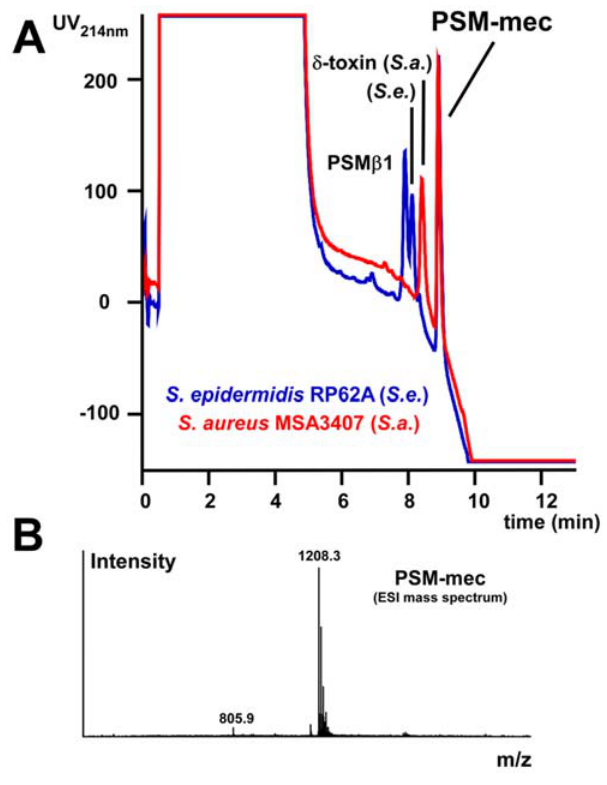
Figure 1. PSM-mec production in S.aureus and S.epidermidis . (A) RP-HPLC elution profile of S. aureus MSA3407 and S. epidermidis RP62A culture filtrates (at 8 h of growth). Equal volumes were applied to a C8 column and eluted with a 0.1% TFA water/acetonitrile gradient. PSM peptides characteristically elute at very high acetonitrile concentrations. Peaks of major PSM peptides and the newly identified PSM-mec are indicated. (B) Electrospray ion chromatogram of the PSM-mec peak obtained by RP/HPLC/ESI-MS ( S. epidermidis RP62A). The respective PSM-mec ESI chromatogram of S. aureus MSA3407 or any strain with PSM-mec production showed the same m/z peaks. The series of peaks with slightly higher masses close to m/z 1208.3 are due to water and sodium adducts.